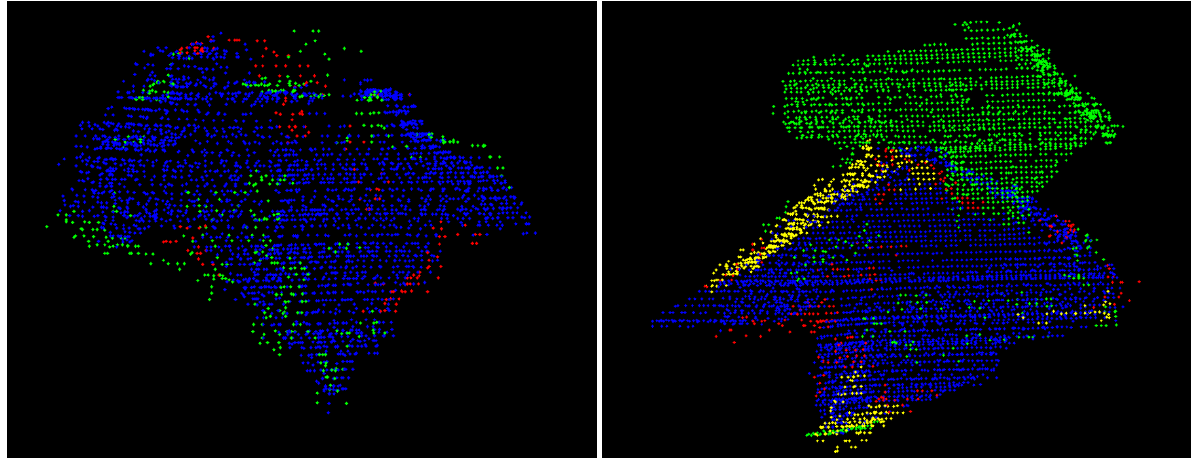
Figure 9. Results of the region merging: surface-based region merging ( left ), edge-based region merging ( right ). The blue-coloured super-segment is complemented by the red-coloured segments (surface-based region merging) as well as by the yellow-coloured segments (edge-based region merging). For the green-coloured segments the test decision is